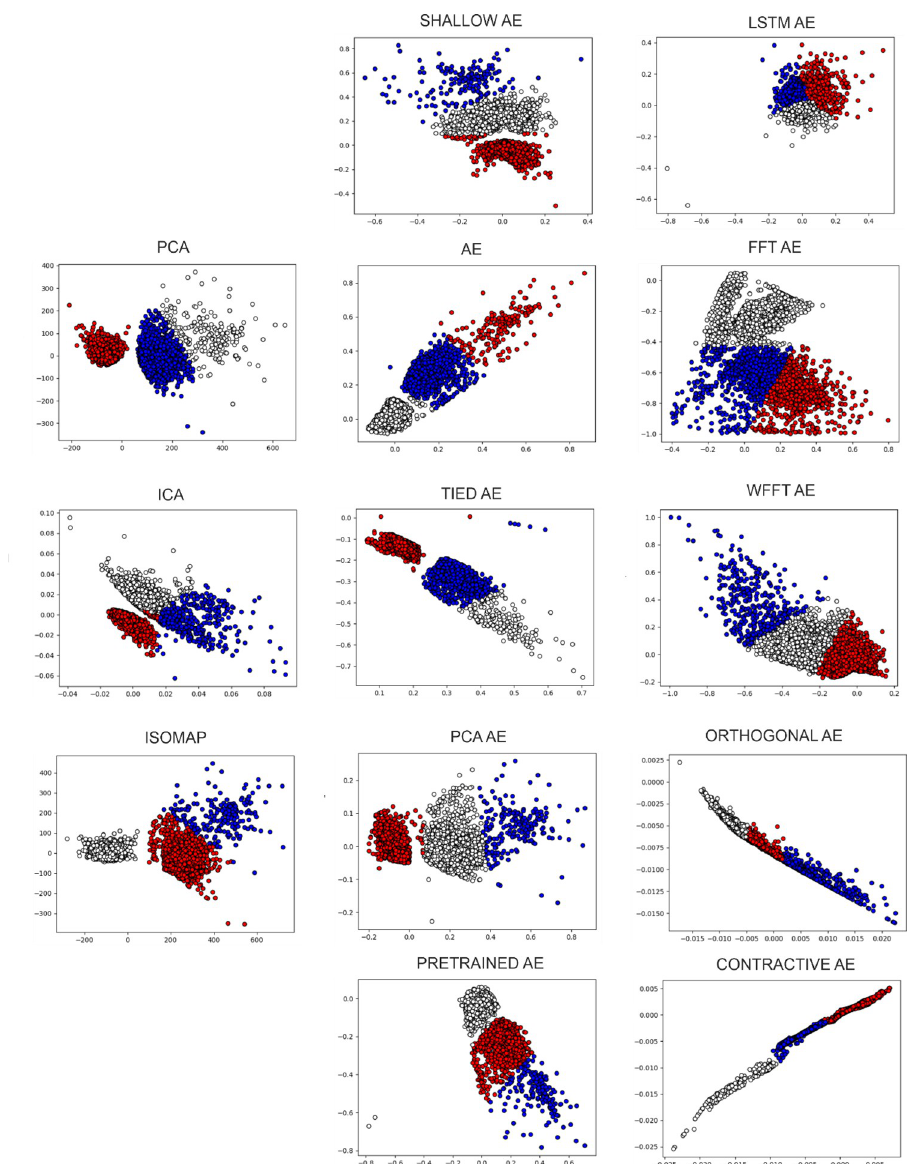
Fig 8. Feature extraction of real data. All feature extraction applied on real data channel 17; the colors present the labelling of K-Means.